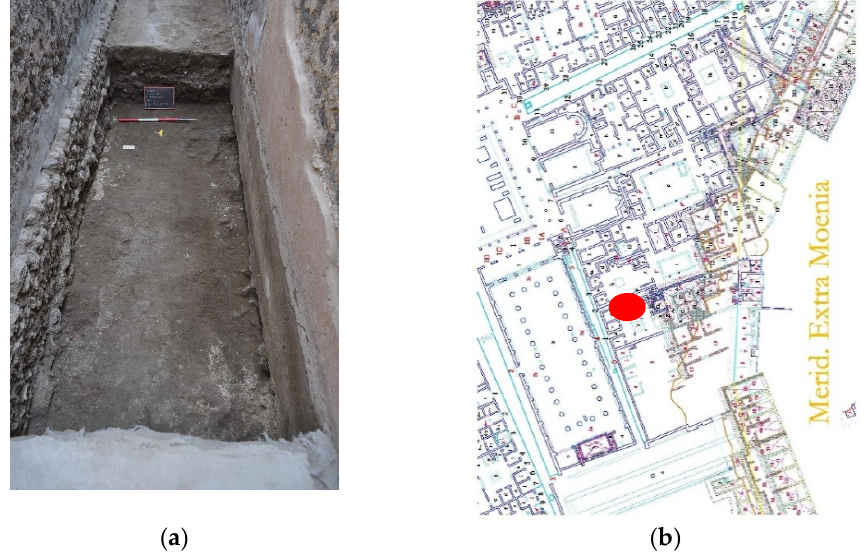
Figure 5. Foundation. ( a ) Excavation at Regio VIII . ( b ) The localization of the excavation (reported in red). Table 1. Soil stratigraphy.